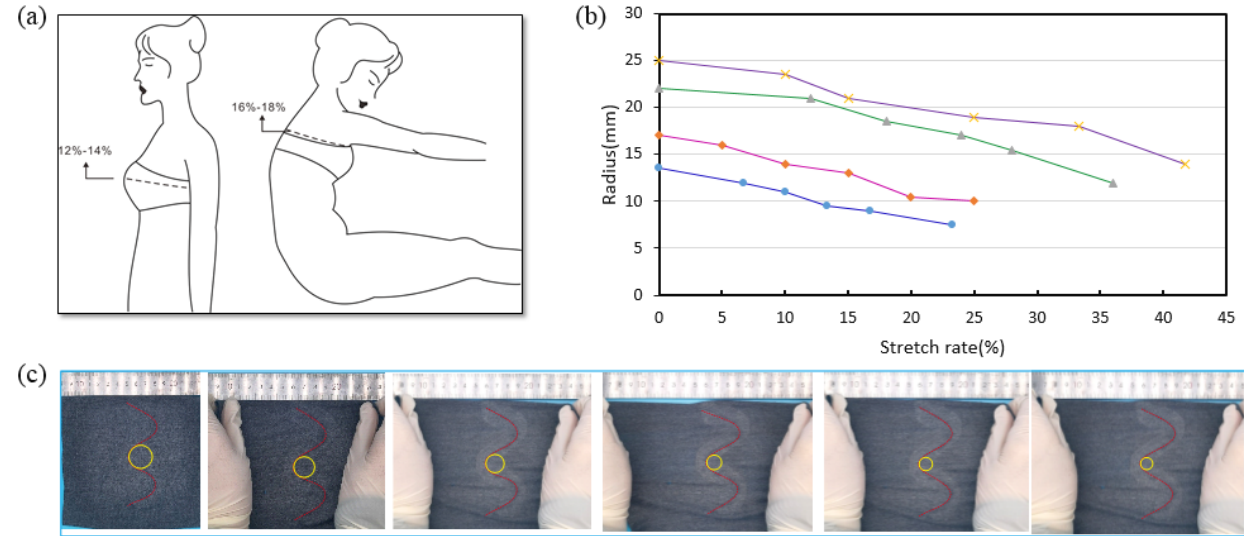
Figure 9. The relationship between the horizontal stretching of the optical fiber path and the bend- ing radius. ( a ) The effect of human movement on the maximum horizontal stretch rate of the garment. ( b ) The relationship between the bending radius and the stretch rate with a different initial bending radius. ( c ) The manual stretching test of the optical fiber path.